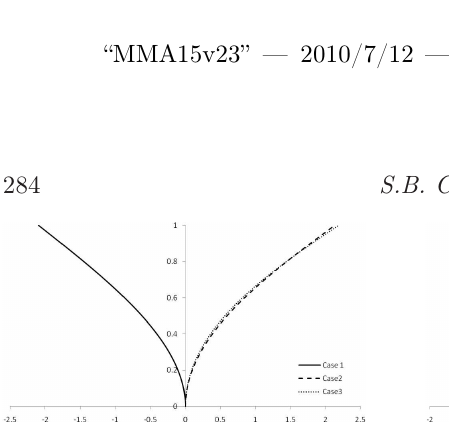
Figure 11. Modeshapes for the first mode – quadratic variation.